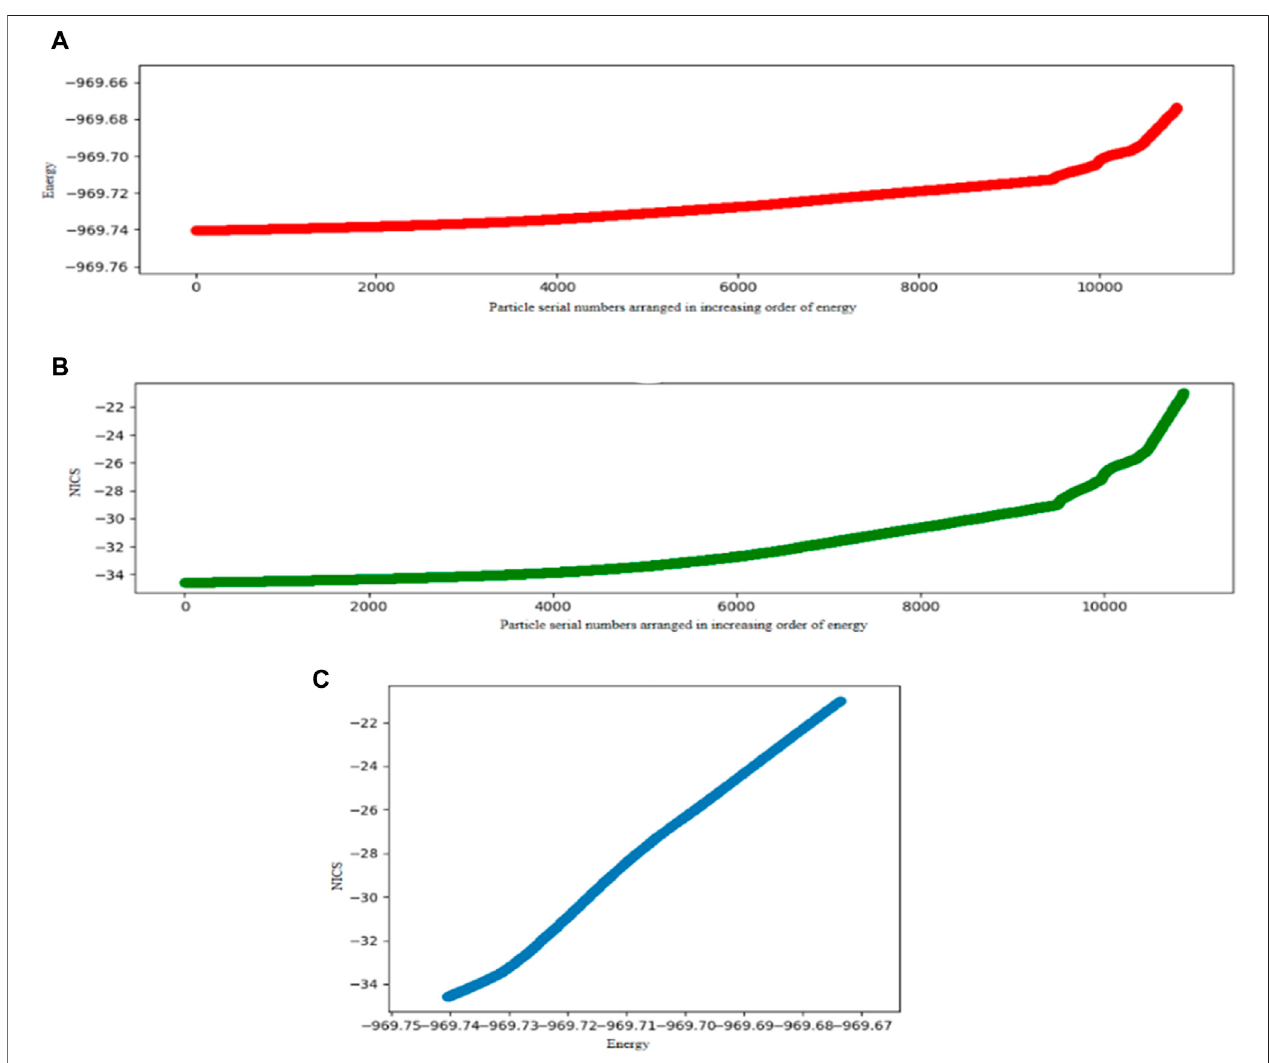
FIGURE4| Energypro fi les(ina.u.)andNucleus-IndependentChemicalShift(NICS)valuesonAl 42- where4 (A) ,4 (B), and4 (C) representplotsofEnergyvs.Particle serial numbers arranged in an increasing order of energy, NICS vs . Particle serial numbers arranged in an increasing order of energy and NICS vs. Energy,